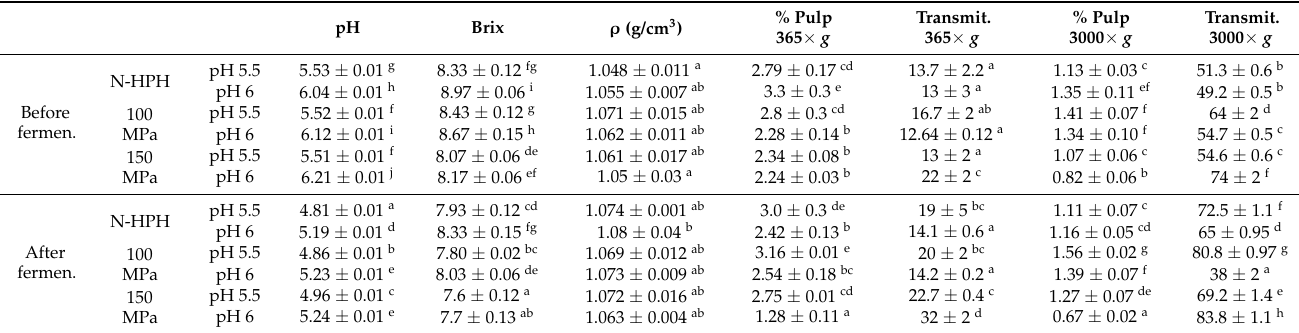
Table 1. Physicochemical properties, before and after fermentation, of lulo juices at pH 5.5 and 6, non-homogenized and homogenized at 100 MPa and 150 MPa. Mean values ± standard deviation. pH Brix ρ (g/cm 3 ) % Pulp 365 × g Transmit. 365 × g % Pulp 3000 × g Transmit. 3000 × g